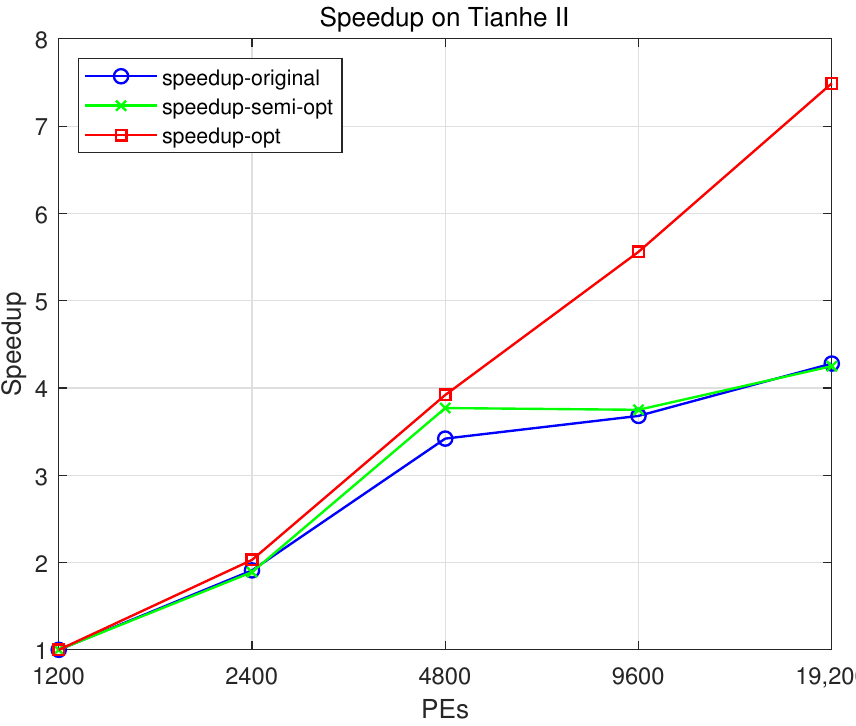
Figure 9. Speedup of LICOM on Tianhe